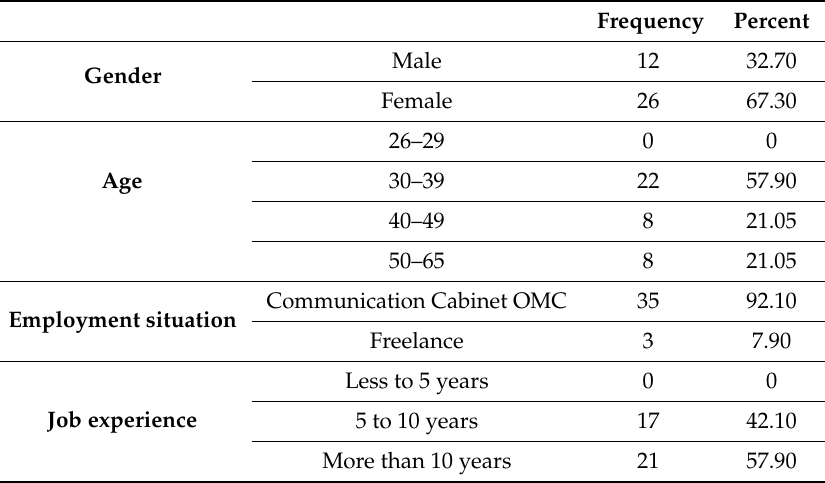
Table 2. Demographic